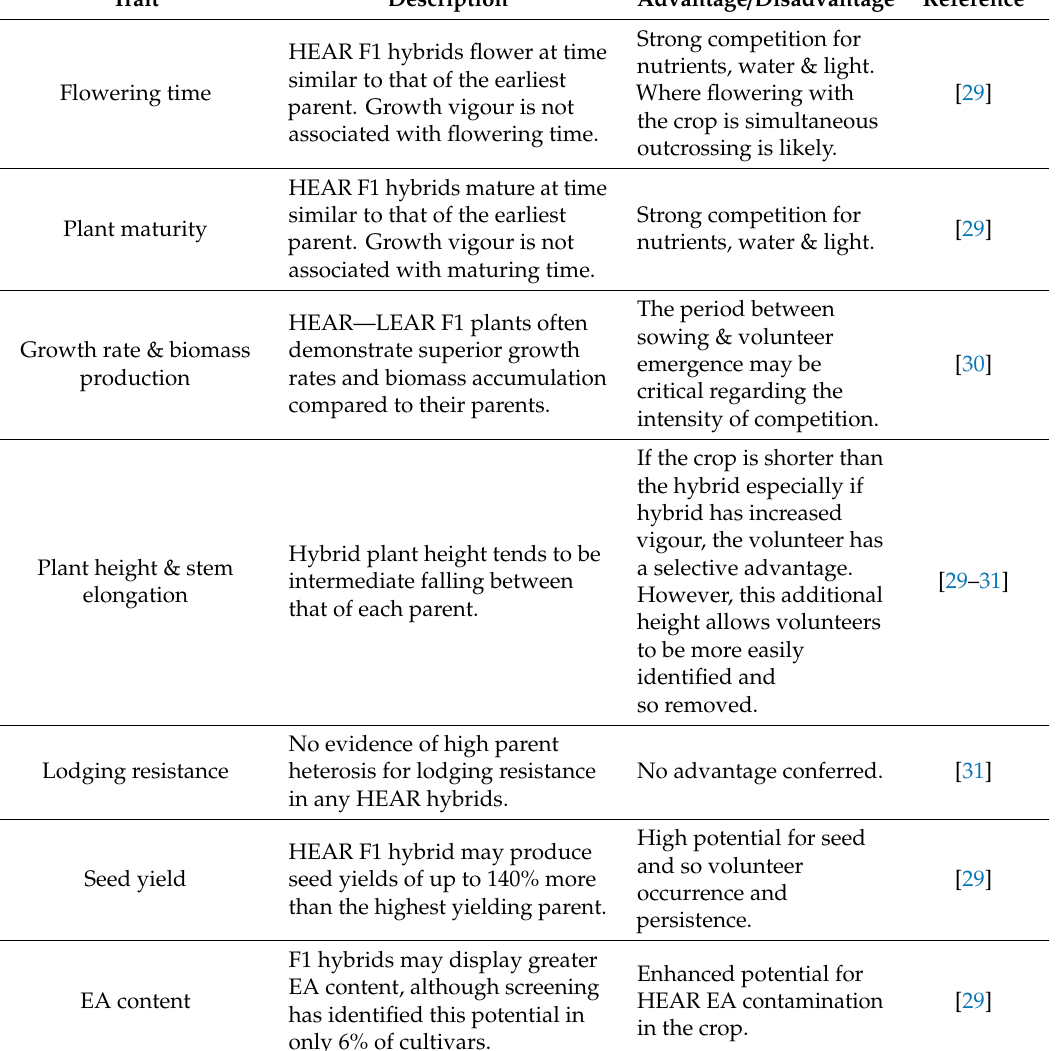
Table 1. Potential morphological traits conferred to hybrid